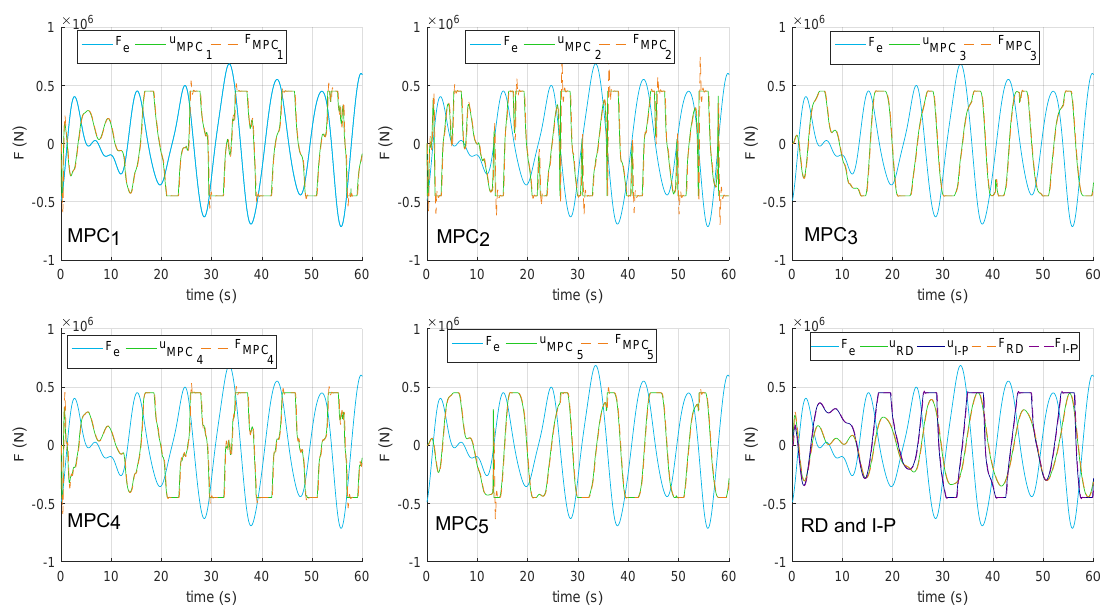
Figure 5. Simulation of: wave force, force setpoint demanded for the PTO and real force produced by the PTO, when applying the seven controllers to the mathematical model (15).